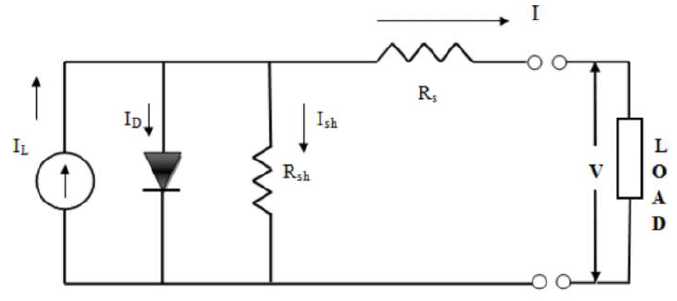
Figure 6. Equivalent circuit for an Al-BRS.